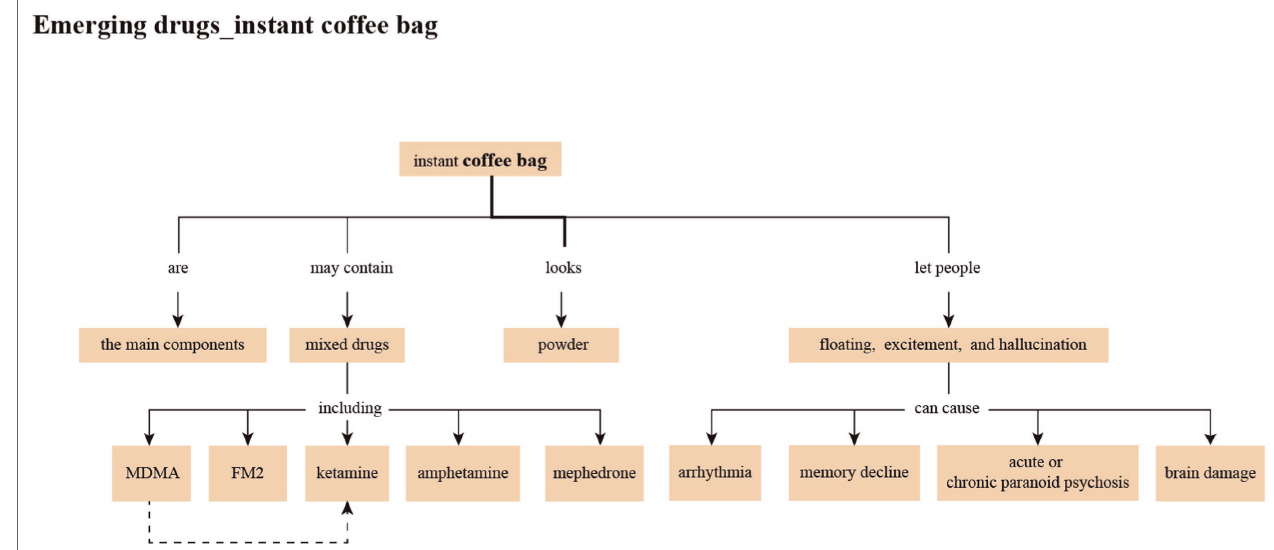
FIGURE 2 | Schematic diagram of conceptual map